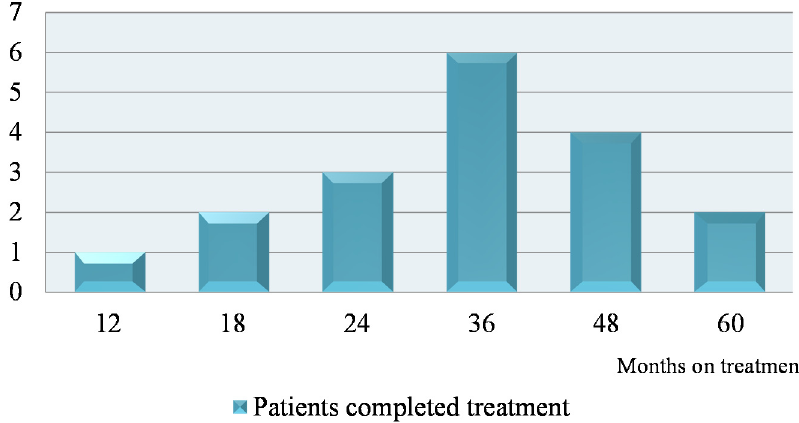
Figure 2. Duration of treatment in patients successfully treated.